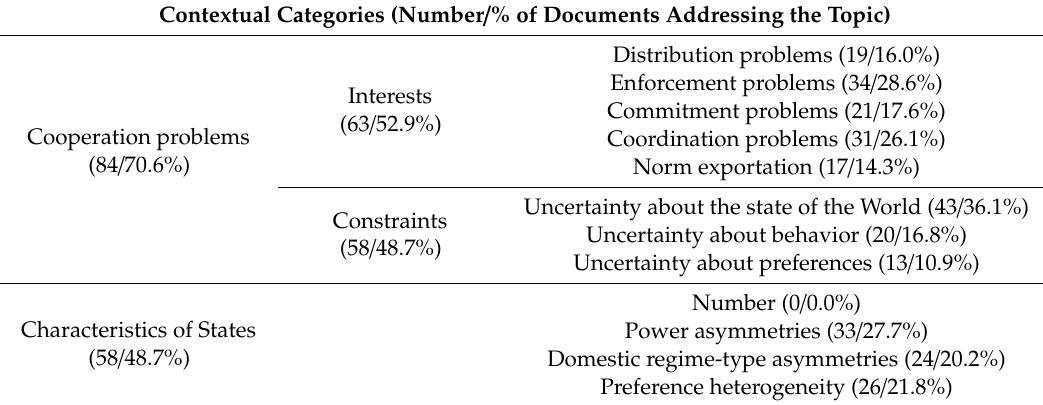
Table 2. Classification of contextual categories and their prevalence in documents.